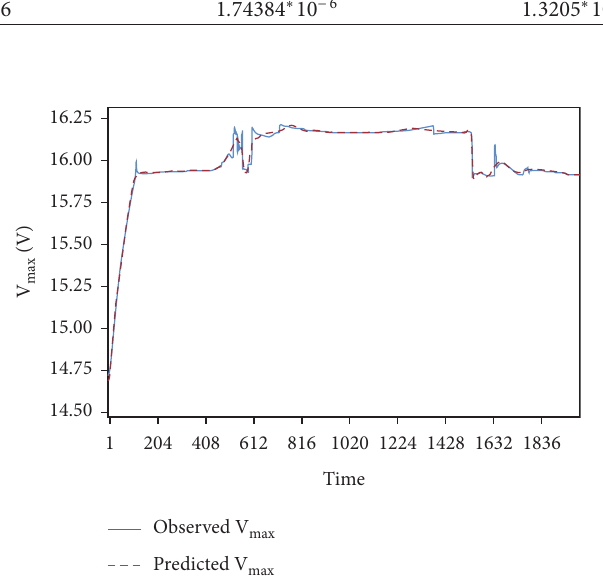
Figure 44: The plot simulated comparing the V